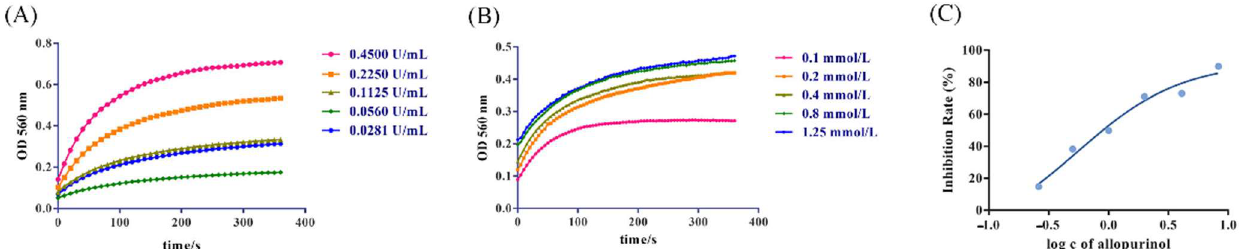
Figure 1. Optimization of XOD catalytic reaction conditions. ( A ) Kinetics of XOD at enzyme con- centrations. ( B ) Kinetics of XOD at substrate concentrations. ( C ) Inhibition rate of allopurinol.